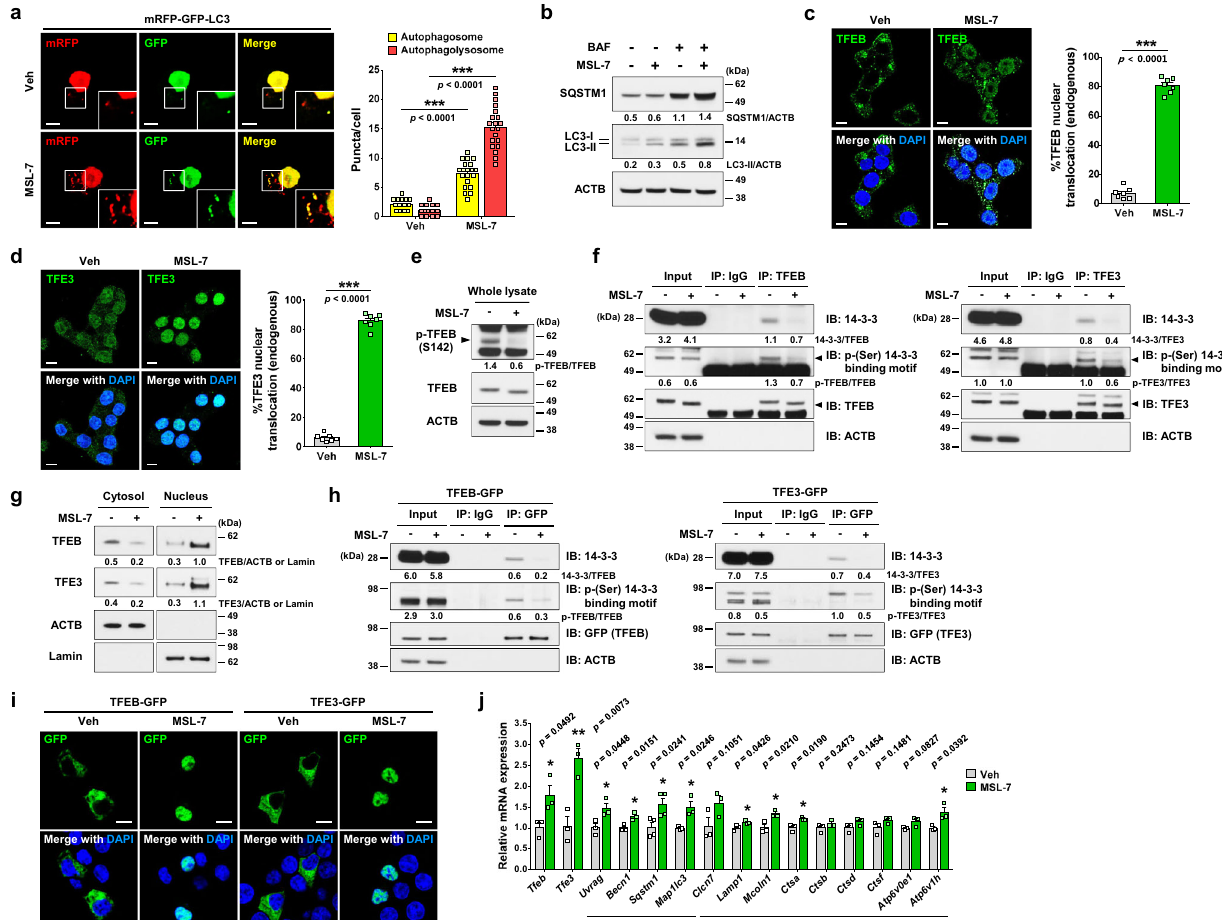
Fig. 1 Activation of TFEB/TFE3 by MSL-7. a INS-1 cells were transfected with mRFP-GFP-LC3 . The numbers of yellow (autophagosomes) and red puncta (autophagolysosomes) were counted ( t = 9.8, df = 38 for autophagosome; t = 17.2, df = 38 for autophagolysosome) (right). Representative pictures are presented (left). Inset images were magni fi ed. b INS-1 cells were treated with MSL-7 in the presence or absence of ba fi lomycin A1 (BAF). Immunoblotting using the indicated antibodies (ACTB, β -actin) were conducted. Numbers indicate fold changes normalized to ACTB bands. c – d Nuclear translocation of TFEB ( c ) and TFE3 ( d ) by MSL-7 was counted ( t = 29.9, df = 12 in c ; t = 38.7, df = 12 in d ) (right of c , d ). Representative pictures are shown (left of c , d ). e INS-1 cells were treated with MSL-7, and immunoblotting using the indicated antibodies were conducted. Numbers indicate fold changes normalized to total TFEB bands. f After lysis of INS-1 cells treated with MSL-7 for 4 h, immunoprecipitation (IP) was conducted using anti-TFEB (left) or anti-TFE3 antibody (right). Supernatant was subjected to immunoblot analysis (IB) using the indicated antibodies. Numbers indicate fold changes normalized to total TFEB or TFE3 bands. g Nuclear and cytosolic fractions of lysates from INS-1 cells treated with MSL-7 were subjected to immunoblot analysis using the indicated antibodies. Numbers indicate fold changes normalized to ACTB bands (cytosol) or Lamin bands (nuclear). h After lysis of Tfeb-GFP- transfected (left) or Tfe3-GFP- transfected cells (right) treated with MSL-7, IP using anti-GFP antibody was conducted. i After treatment of Tfeb-GFP- transfected or Tfe3-GFP -transfected cells with MSL-7, confocal microscopy was conducted. Numbers indicate fold changes normalized to GFP bands. j Real-time RT-PCR was performed using mRNA from INS-1 cells treated with MSL-7 for 6 h and speci fi c primers. All data in this fi gure are the means± SEM from more than 3 independent experiments performed in triplicate. (scale bar, 5 μ m) * P < 0.05; ** P < 0.01; *** P < 0.001 by two-tailed Student ’ s t -test ( a , c , d , j ). Source data are provided as a Source Data fi